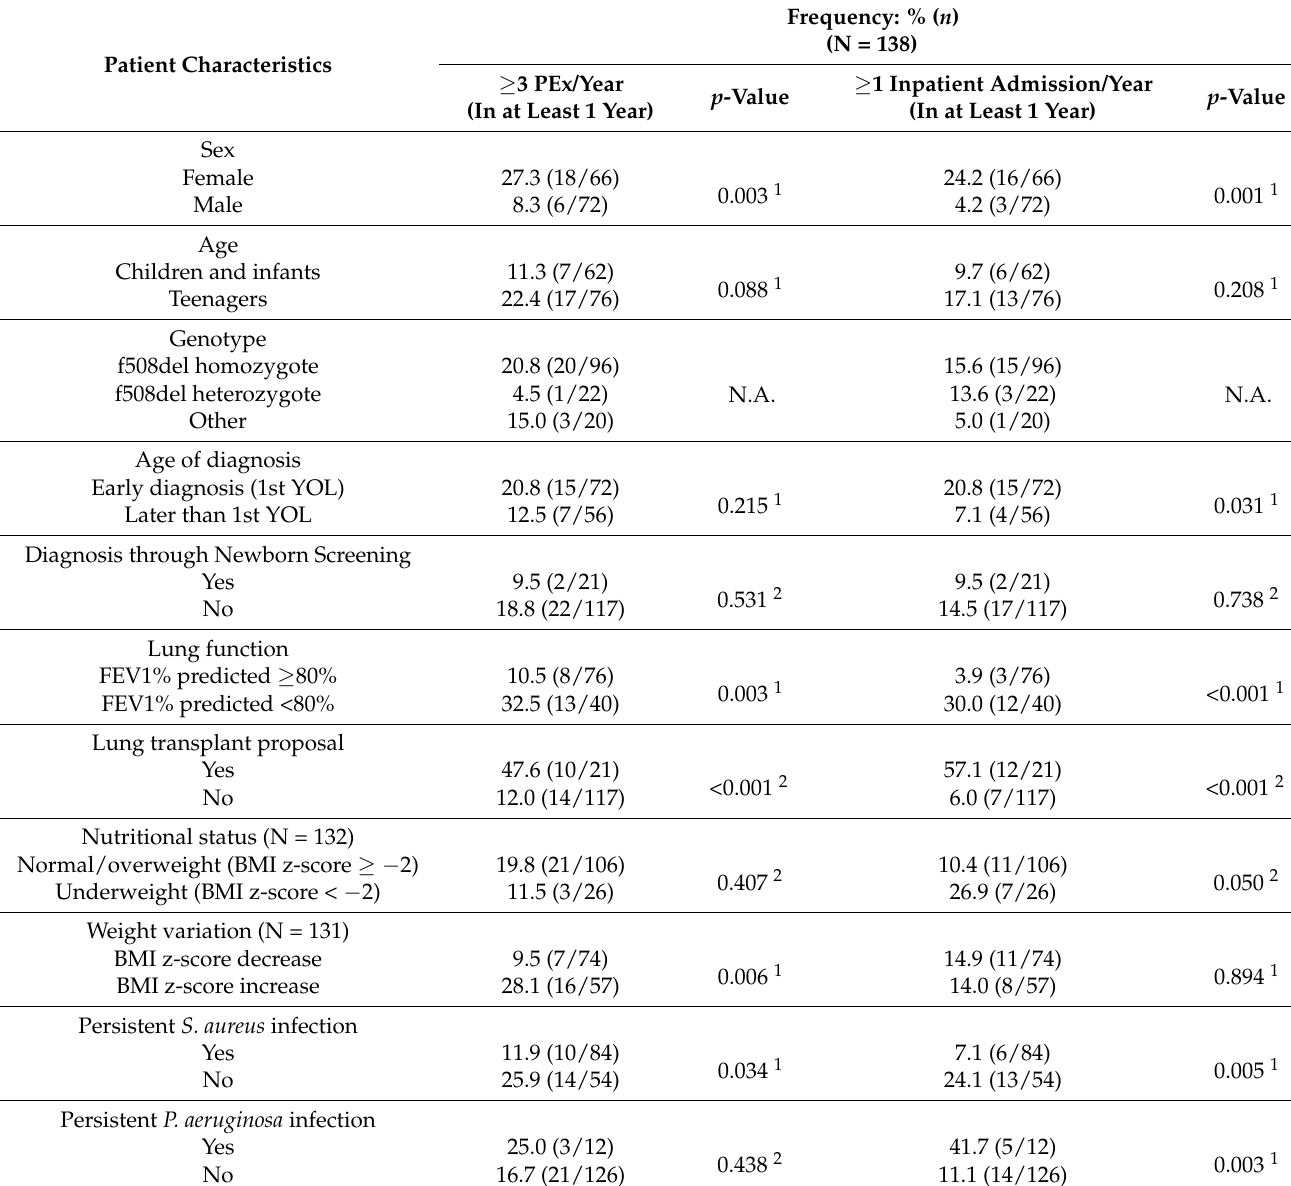
Table 2. Comparison of frequency of PEx and hospital admissions between patient